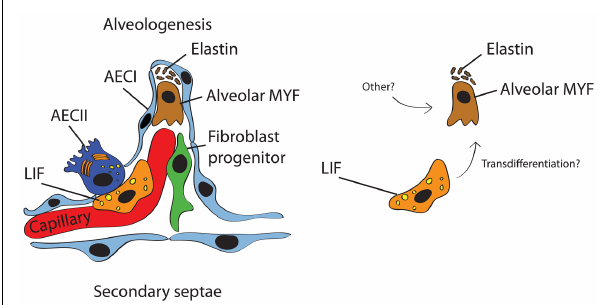
FIGURE 2 | Schematic representation of the secondary septum during alveologenesis . Most of the alveolar surface is occupied by AECI (gas exchange) whereas a minor surface is occupied by AECII (surfactant production). The alveolar wall consists of the blood capillary, LIF, resident fibroblast progenitor, alveolar MYF, and ECM (mostly elastin). It has been proposed that alveolar MYF can originate from LIF (right panel) but this concept needs further